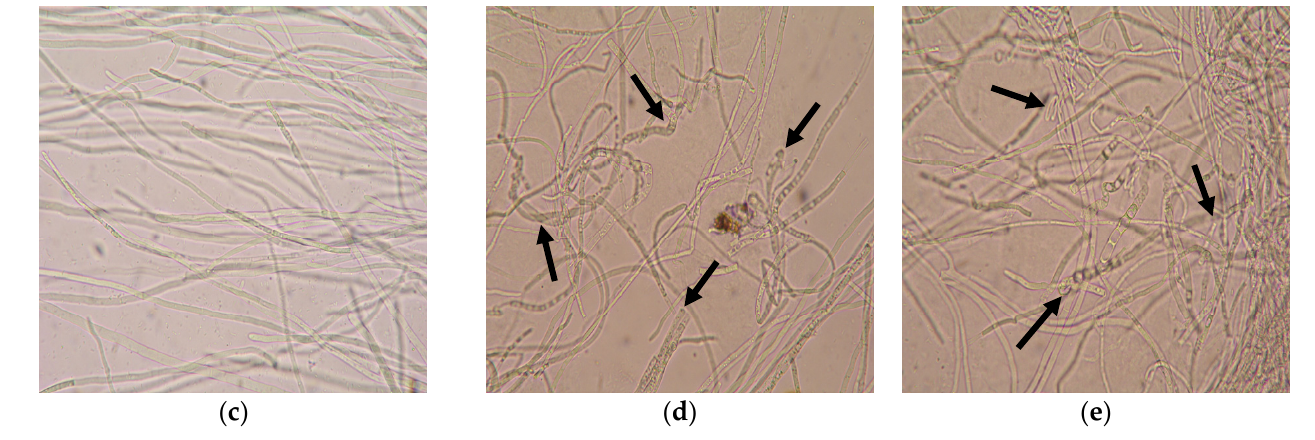
Figure 5. Effect of culture filtrate of Acr. jodhpurensis MR-57 on the hyphal morphology of F. equiseti . ( a ) PDA media inoculated only with F. equiseti . ( b ) Mycelia of F. equiseti cultures on PDA in the presence of culture filtrate of Acr. jodhpurensis MR-57. ( c ) Healthy mycelia of F. equiseti. ( d , e ) Microscopic observation of mycelial growths of F. equiseti during co-culture assay with the absence or presence of culture filtrate of Acr. jodhpurensis MR-57.